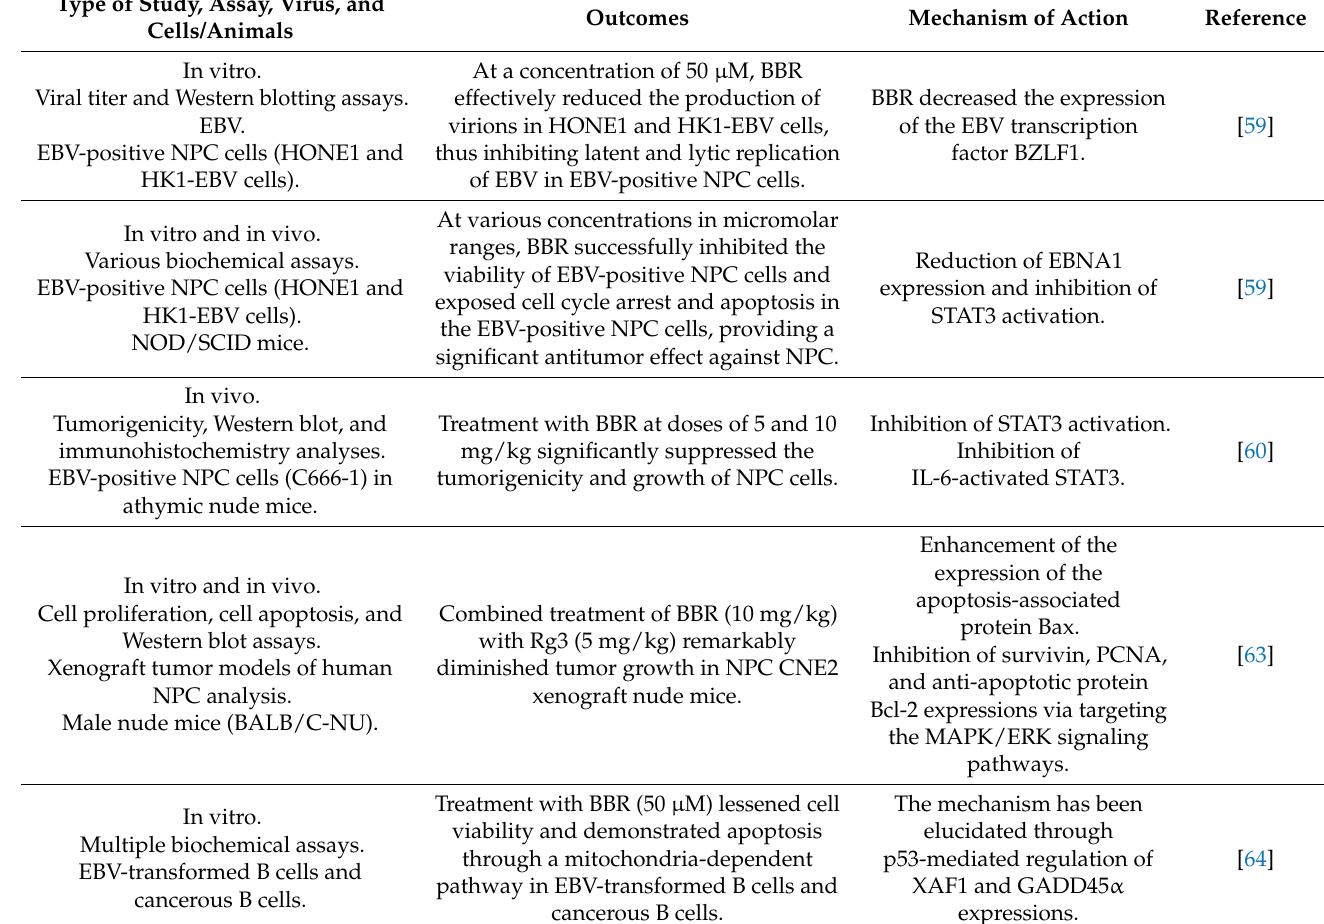
Table 1. Protective effects of berberine against Epstein–Barr virus and its linked tumors. Type of Study, Assay, Virus, and Outcomes Mechanism of Action Cells/Animals